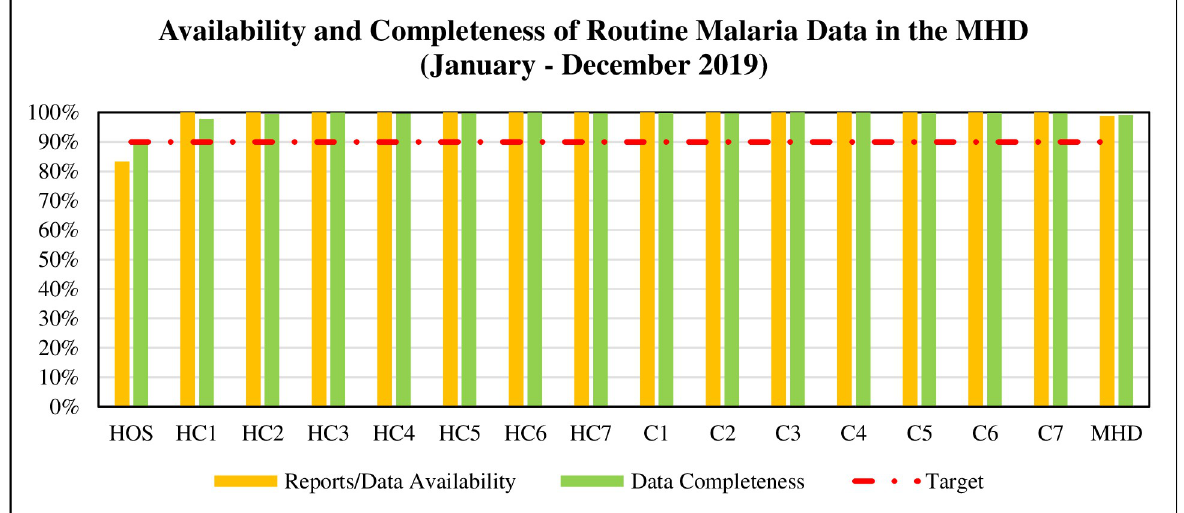
Fig 3. Availability and completeness of routine malaria data. Source: Survey, 2021.